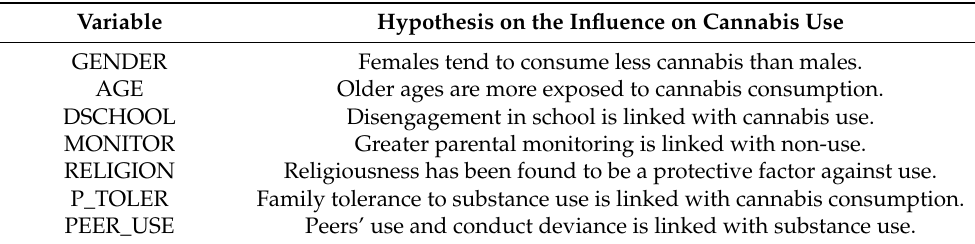
Table 3. Hypotheses used to find intermediate